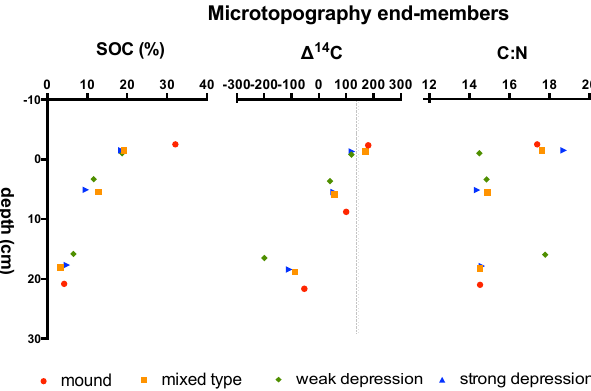
typeC:N ratio strong depressionC:N ratio weak depression C:N ratio mixed